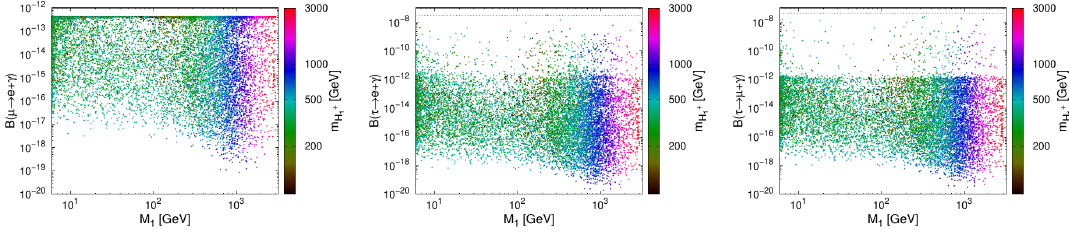
Figure 4 . The branching ratio of the LFV processes µ → e + γ , τ → e + γ and τ → µ + γ versus the light Majorana singlet fermion, where the palette shows the light charged scalar mass. The dashed horizontal line in each panel represents the branching ratio experimental